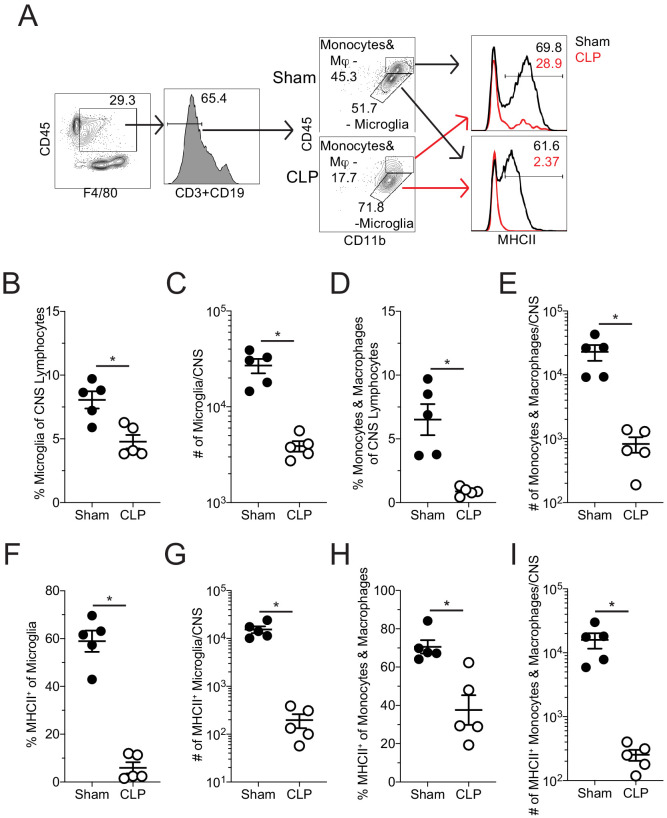
Reduced representation and number of activated microglia, monocytes, and macrophages in the CNS of CLP mice following EAE immunization.Sham and CLP mice were immunized s.c. with MOG35-55 emulsified in complete Freunds adjuvant (CFA) on both flanks 5 days after surgery and given pertussis toxin (PTX) i.p. on the day of immunization as well as 2 days later to induce EAE. Mice were perfused 15 days post-EAE induction and CNS was harvested. (A) Representative gating of CNS monocytes/macrophages and microglia as well as expression of MHCII by gated cells. Frequency (B) and number (C) of microglia in the CNS. Frequency (D) and number (E) of monocytes and macrophages in the CNS. Frequency (F) and number (G) of MHCII-expressing microglia in the CNS. Frequency (H) and number (I) of MHCII-expressing monocytes and macrophages in the CNS. Data are from one experiment with five mice per group. *p<0.05. Error bars represent the standard error of the mean.
Figure 1—figure supplement 3—source data 1.Source data for Figure 1—figure supplement 2.